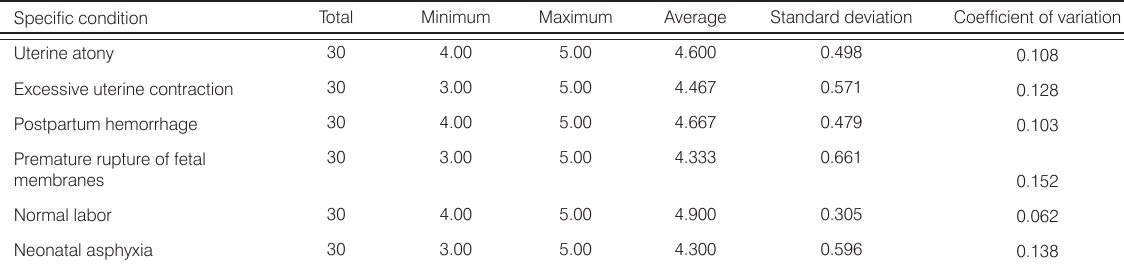
Table 11. Statistics on the acceptance of conditions for midwives practicing prescriptive authority (Round